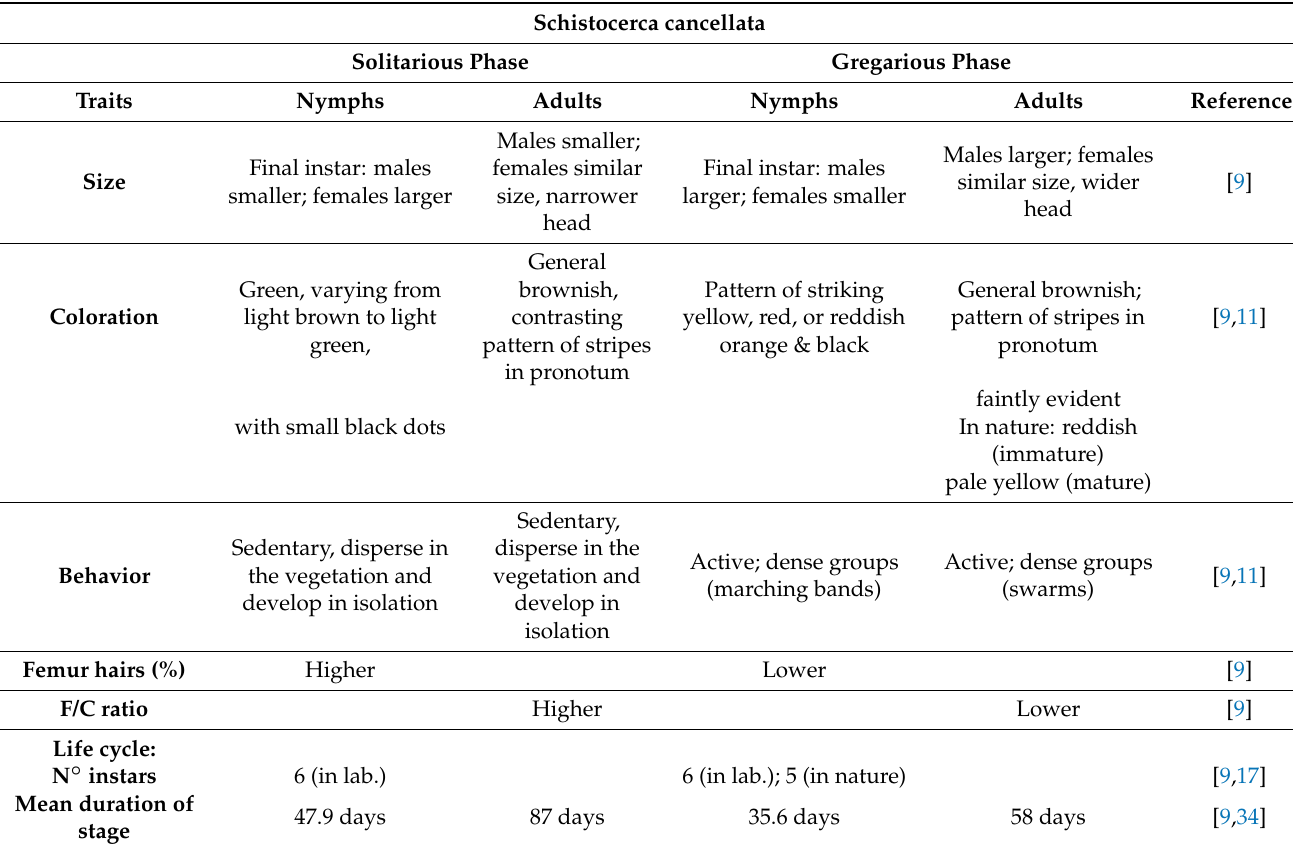
Table 1. Summary of the main differences between solitarious and gregarious phases for the nymphal and adult stages of Schistocerca cancellata